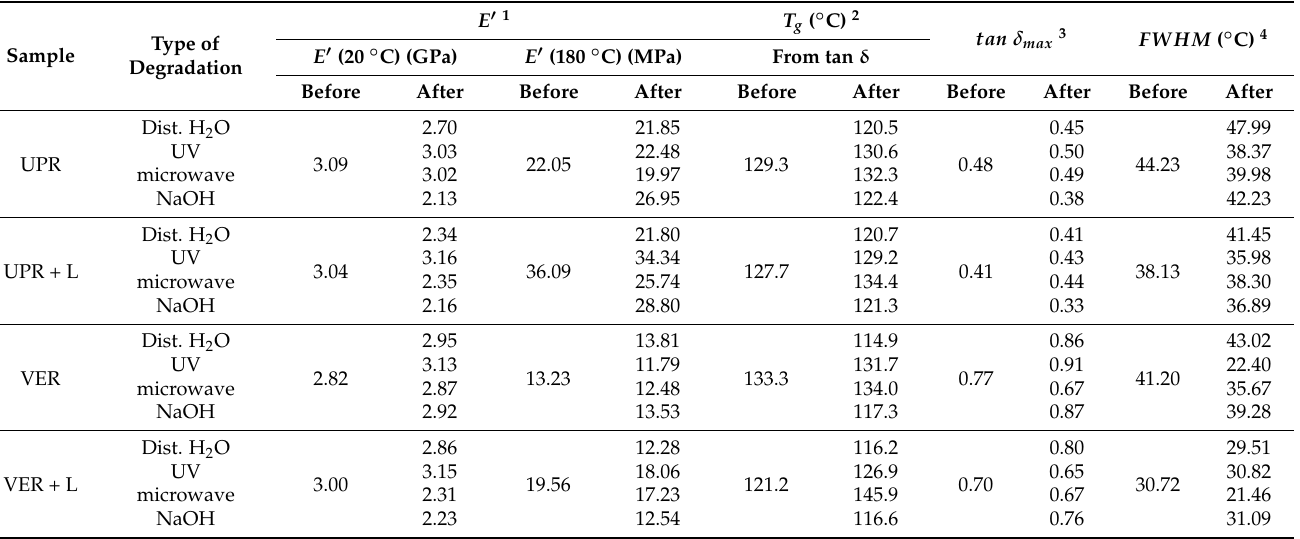
Table 4. Thermomechanical data for the UPR and VER composites with kraft lignin before and after